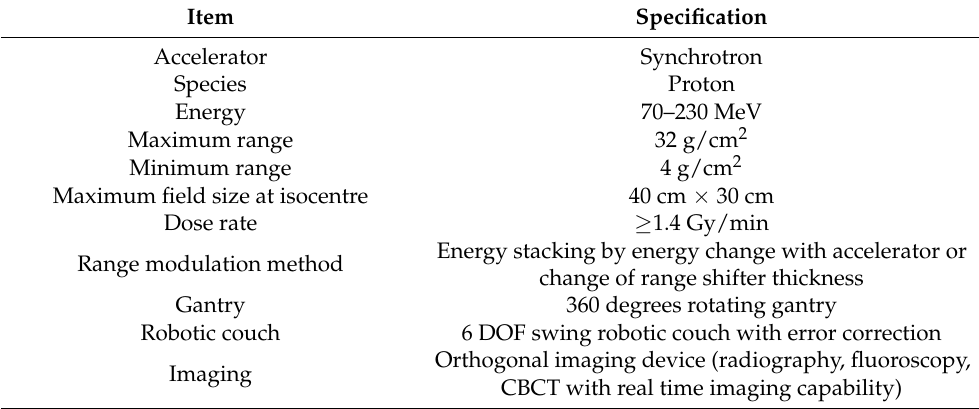
Table 4. Main characteristics of the Hitachi system to be installed at CNAO. Item